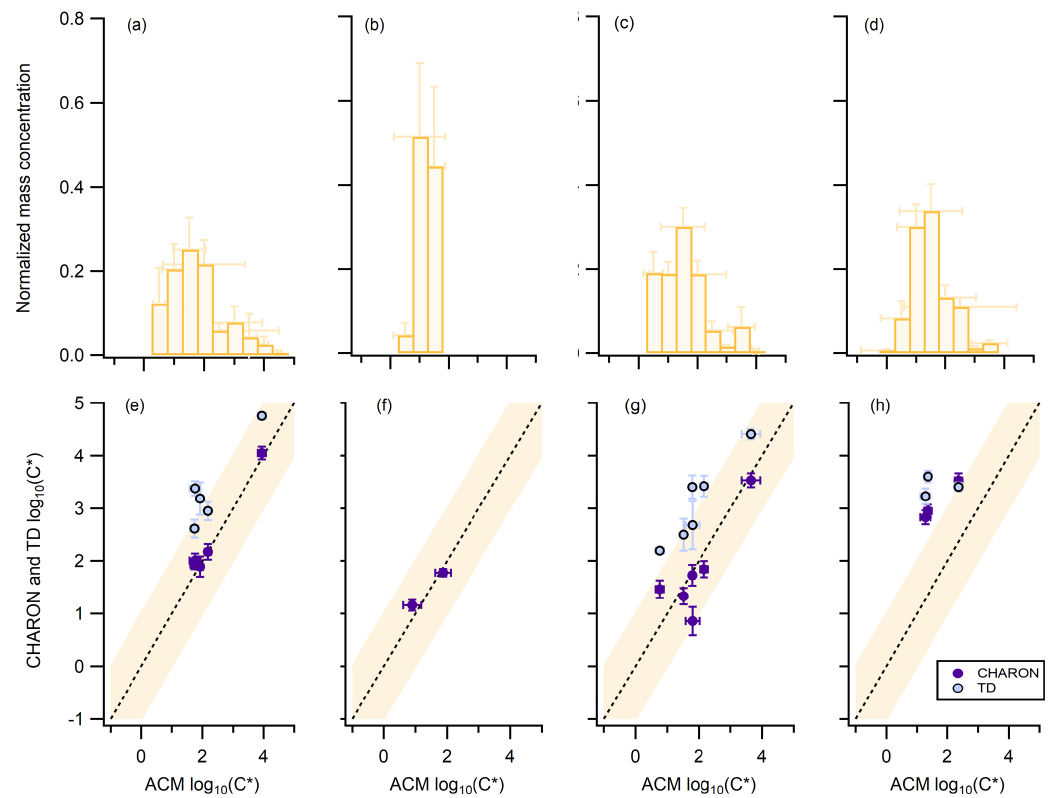
Figure 2. Oxidation experiments using (a, e) β -pinene, (b, f) limonene, (c, g) a mixture of β -pinene and limonene, and (d, h) real tree emissions from Pinus sylvestris L. (Scots pine) as a precursor. Panels (a, b, c, d) correspond to the normalized average mass concentration from ACM, CHARON, and TD, distributed to the different volatility bins with a volatility resolution of 0.5µgm − 3 . Panels (e, f, g, h) correspond to the average volatility of overlapping compounds seen from CHARON and ACM (purple circles) or TD and ACM (blue circles). The dash line represents the 1 : 1 line. The orange background color indicates the ± 1µgm − 3 deviation from the 1 : 1 line. Error bars correspond to the ± 1 σ of the average throughout each